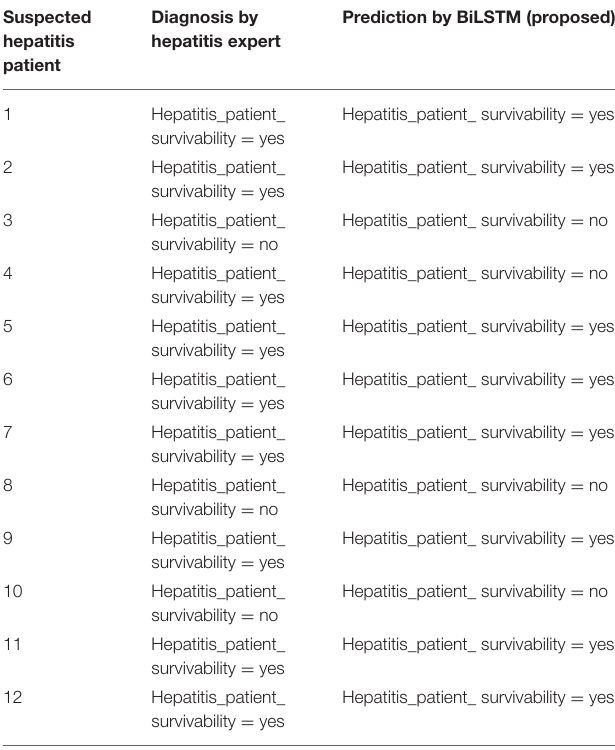
TABLE 5 | Human expert vs. proposed system prognosis. Suspected